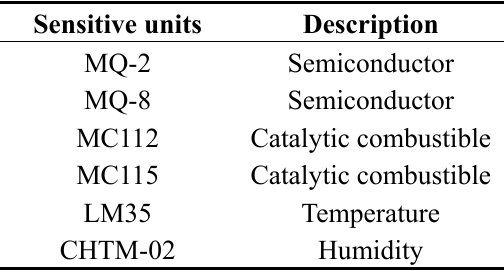
Table 3. Lists of sensitive